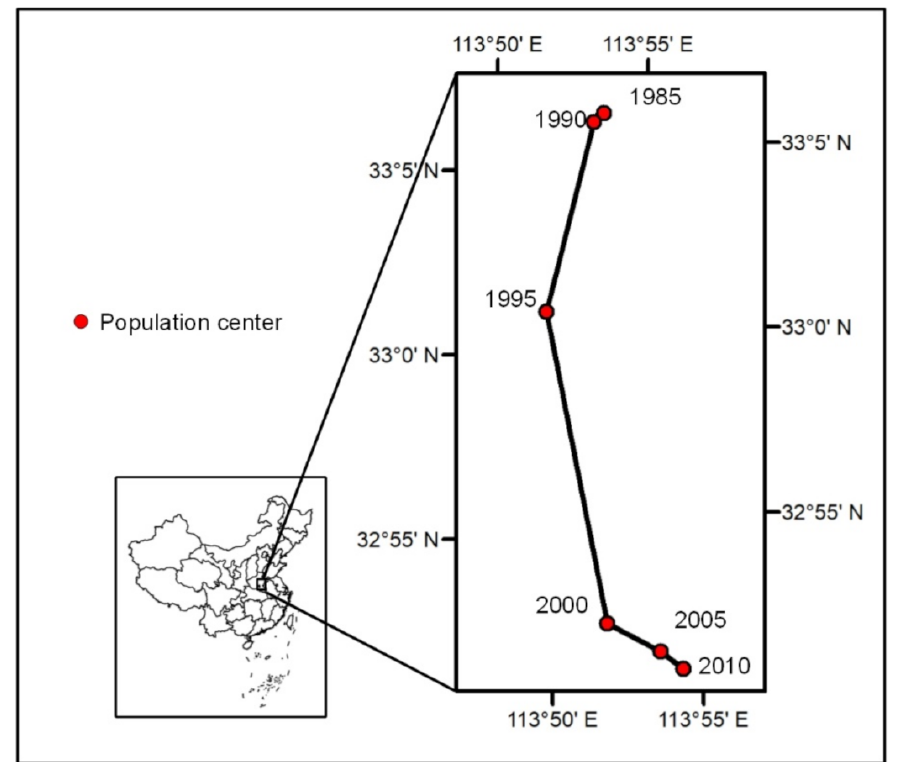
Figure A2. The movement path of population center in China from 1985 to